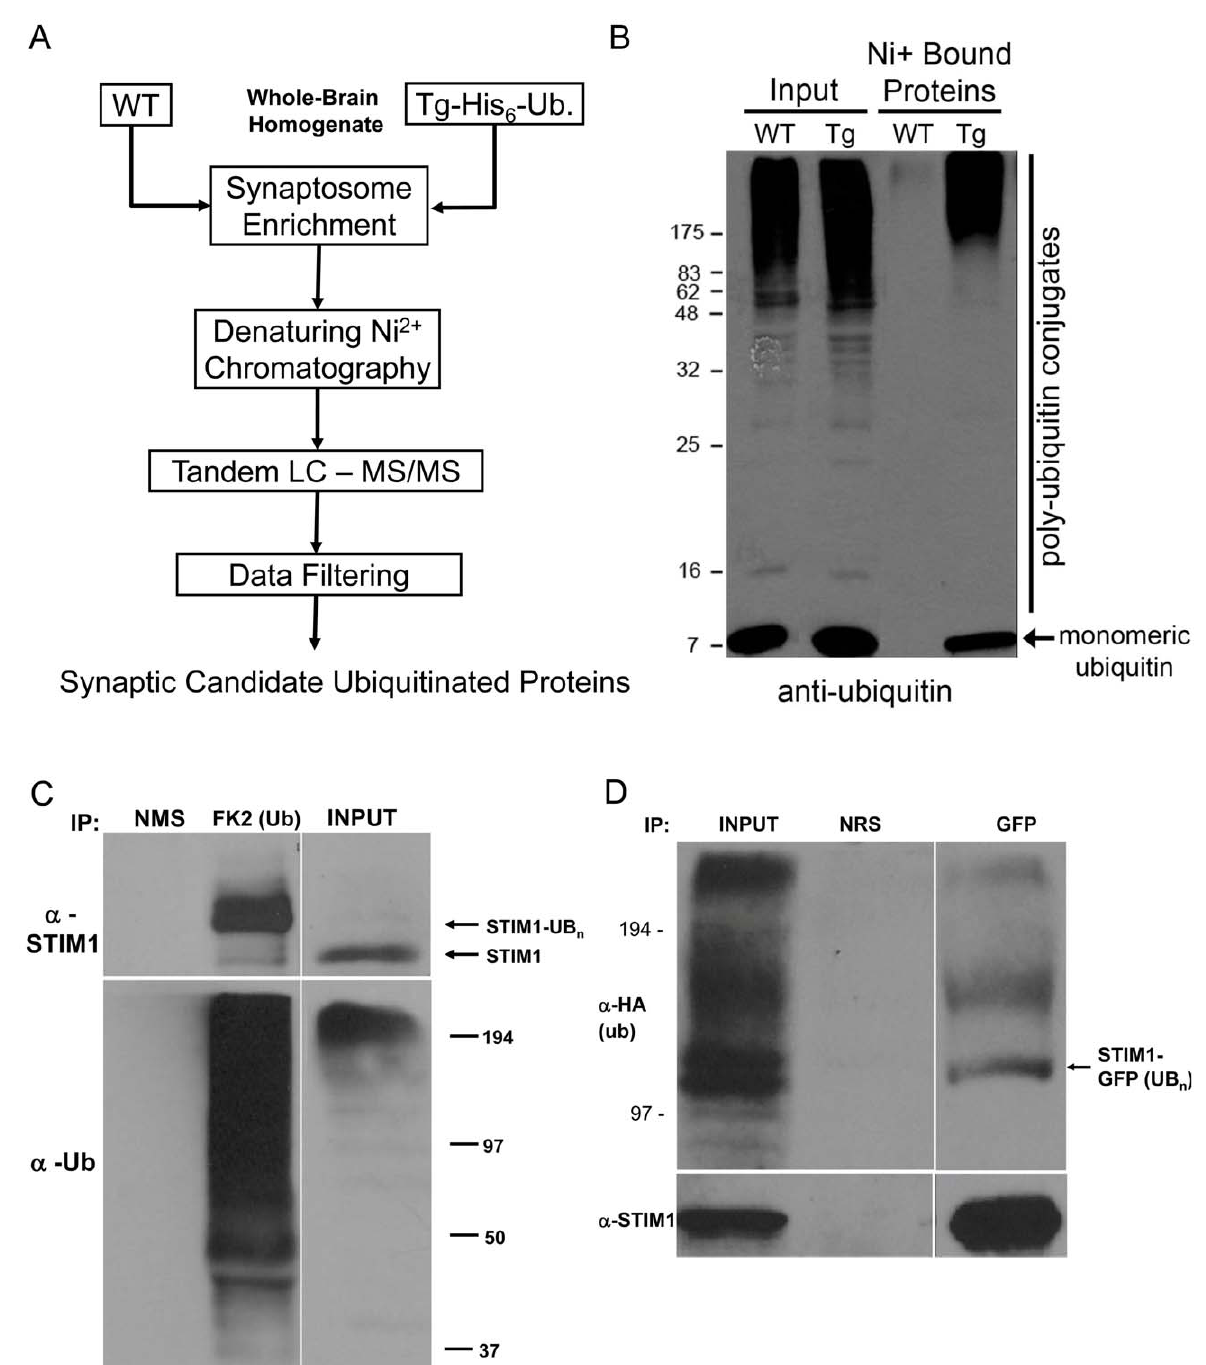
Figure 3. Isolation and identification of synaptic ubiquitinated proteins. (A) Schematized overview of proteomic screen for the isolation and identification of synaptic ubiquitinated proteins from mice expressing a hexahistidine-tagged ubiquitin GFP fusion transgene under the human UbC promoter (Tg-Ub mice). (B) Representative immunoblot depicting the ubiquitin immunoreactivity in Tg-Ub and WT (non-Tg) P2 9 synaptosomal membrane total lysates or following nickel-affinity purification. (C) Adult rate brain P2 9 synaptosomal membranes were solubilized and then immunoprecipitated with either a -STIM1 or a -ubiquitin (FK2). Immune complexes were resolved by SDS-PAGE and subjected to western blot analysis with a -STIM1 (top) or a -ubiquitin (bottom) antibodies Arrow indicates the relative mobility of unmodified STIM1. (D) HA-ubiquitin and STIM1-GFP were co-expressed in HEK293 cells. The resulting lysates were subjected to immunoprecipitation with either a -GFP or control serum (normal rabbit serum, NRS). Arrow indicates the relative mobility of monoubiquitinated-STIM1GFP. Representative blots depicted from 2 to 3 independent experiments for C and D.